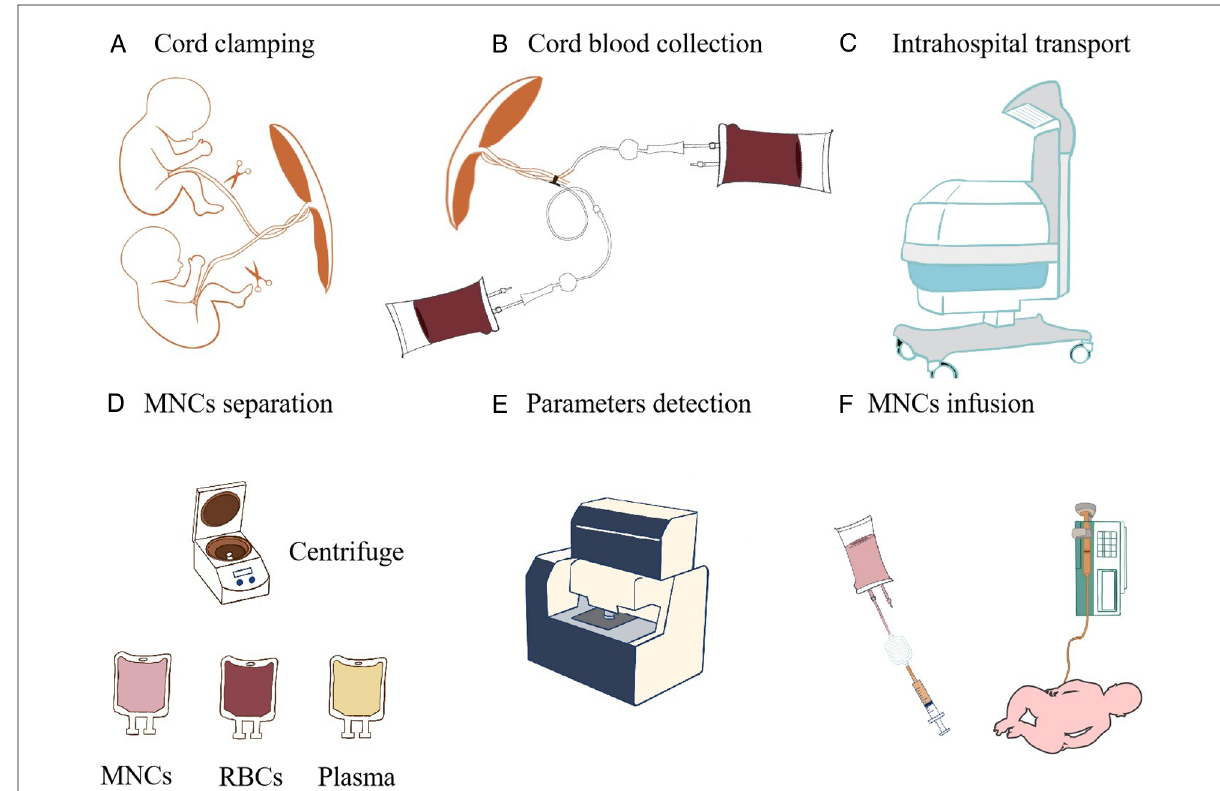
FIGURE 2 Cord blood processing fl ow diagram. ( A ) Cord clamping. ( B ) Cord blood collection. ( C ) Intrahospital transport. ( D ) MNC separation after centrifugation. ( E ) Parameter detection. ( F ) MNCs are infused by using a light-blocking infusion tube and placing an IV line